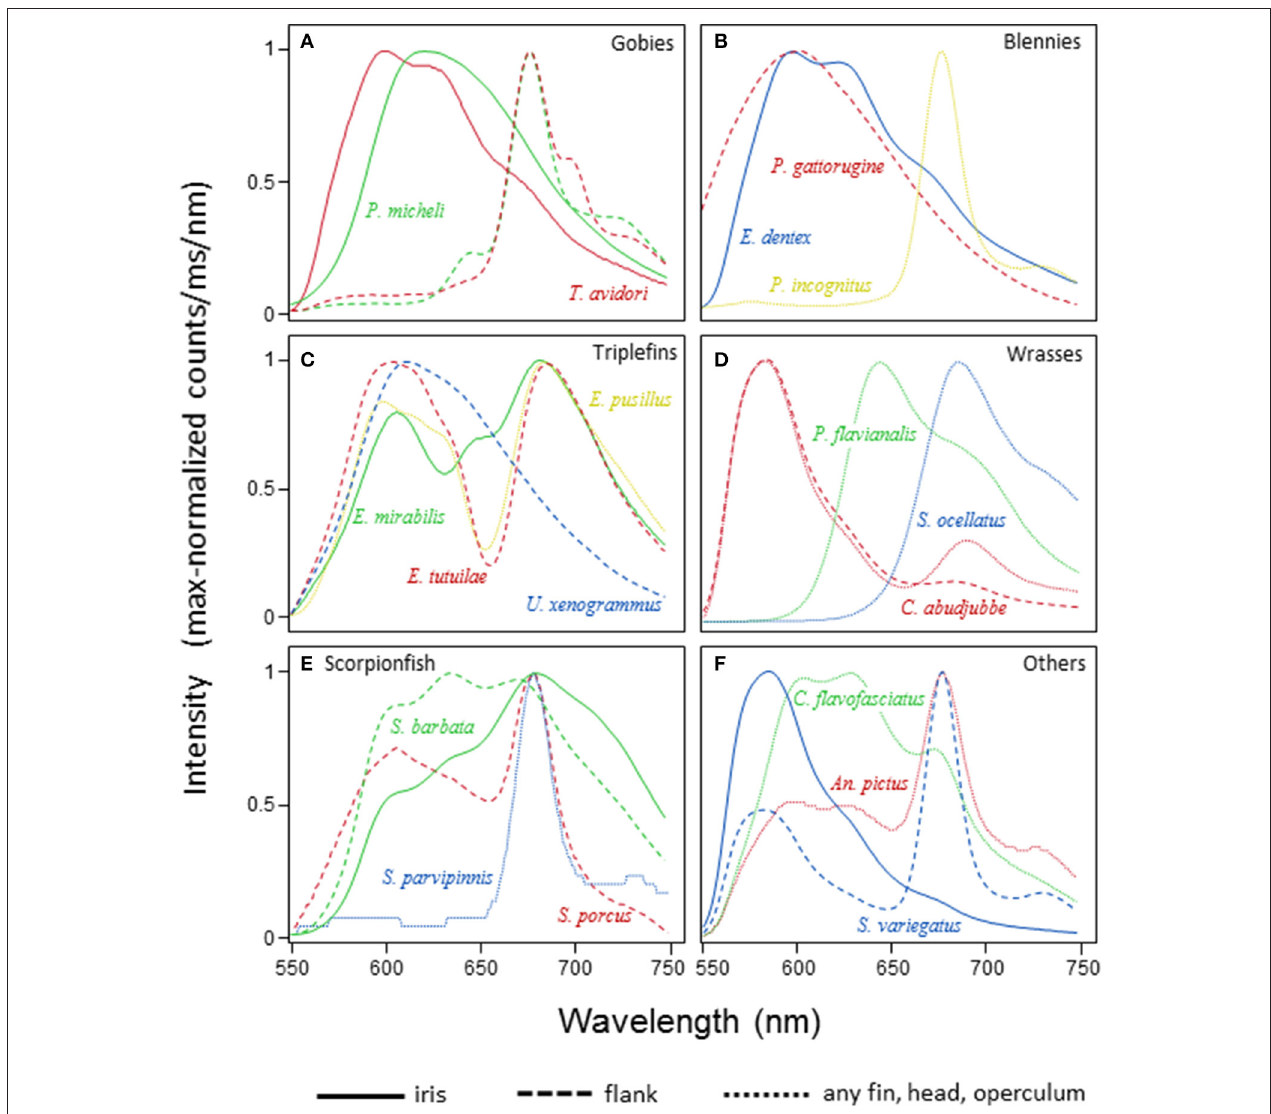
FIGURE 7 | Spectral patterns of red fluorescence. For a selection of families and species, the graphs depict the maximum-normalized shape of fluorescent emission under monochromatic green excitation (see Methods). Within each panel, species are coded by color, body parts by line styles. (A) Gobiidae, (B) Blenniidae, (C) Tripterygiidae, (D) Labridae, (E) Scorpaenidae, (F) Syngnathidae, Antennariidae, and Synodontidae.